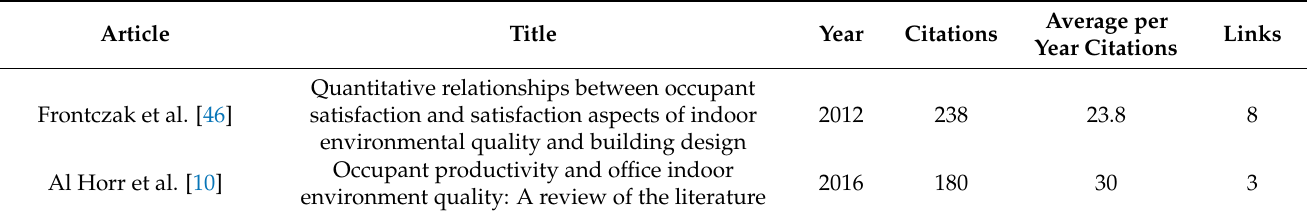
Table 2. Highly cited papers in the field of